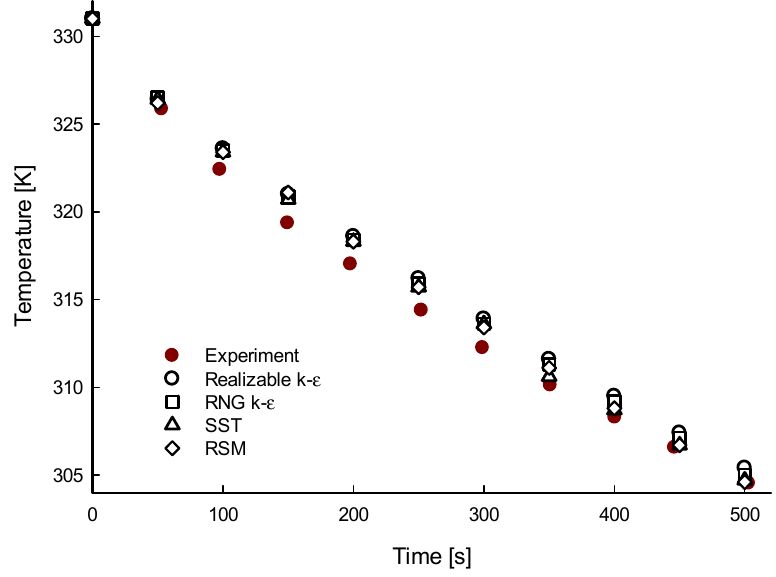
Figure 4. Comparison of the average gas temperature during discharging obtained by the different turbulence models.